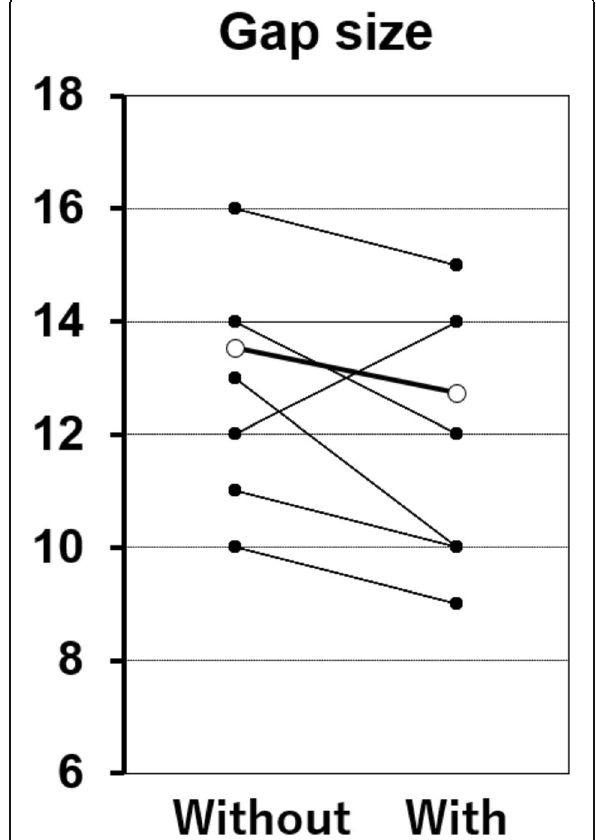
Fig. 3 Gap size. The joint gap size during 90° flexion without (left) and with (right) the trial component. ( ○ : mean gap size)